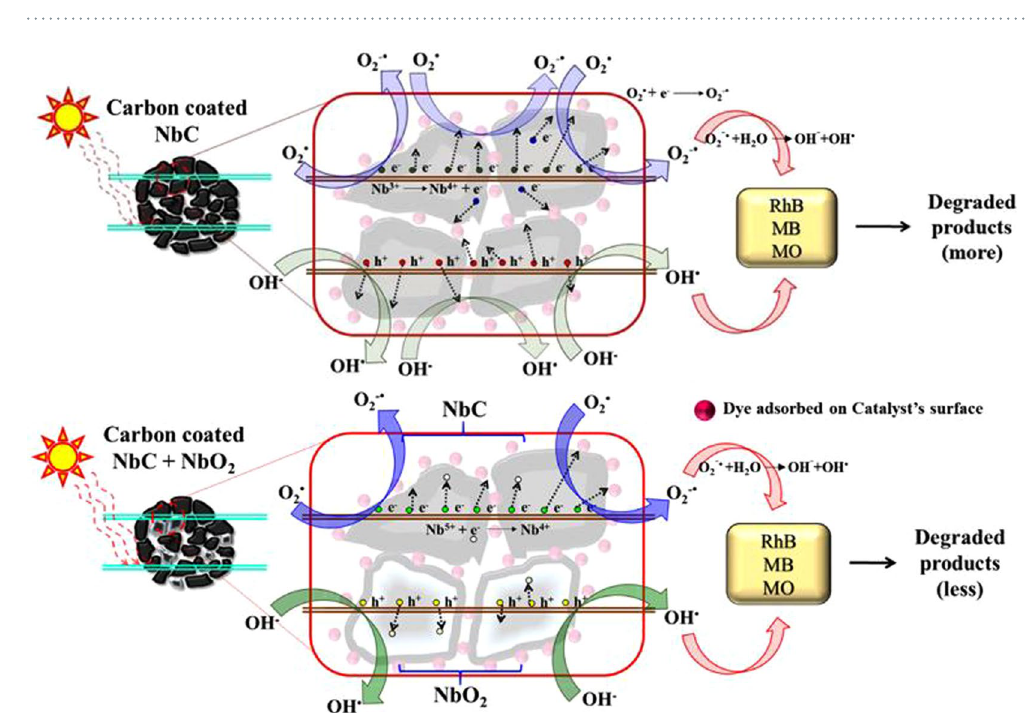
Figure 16. Mechanism of the mineralization of dyes (RhB, MB and